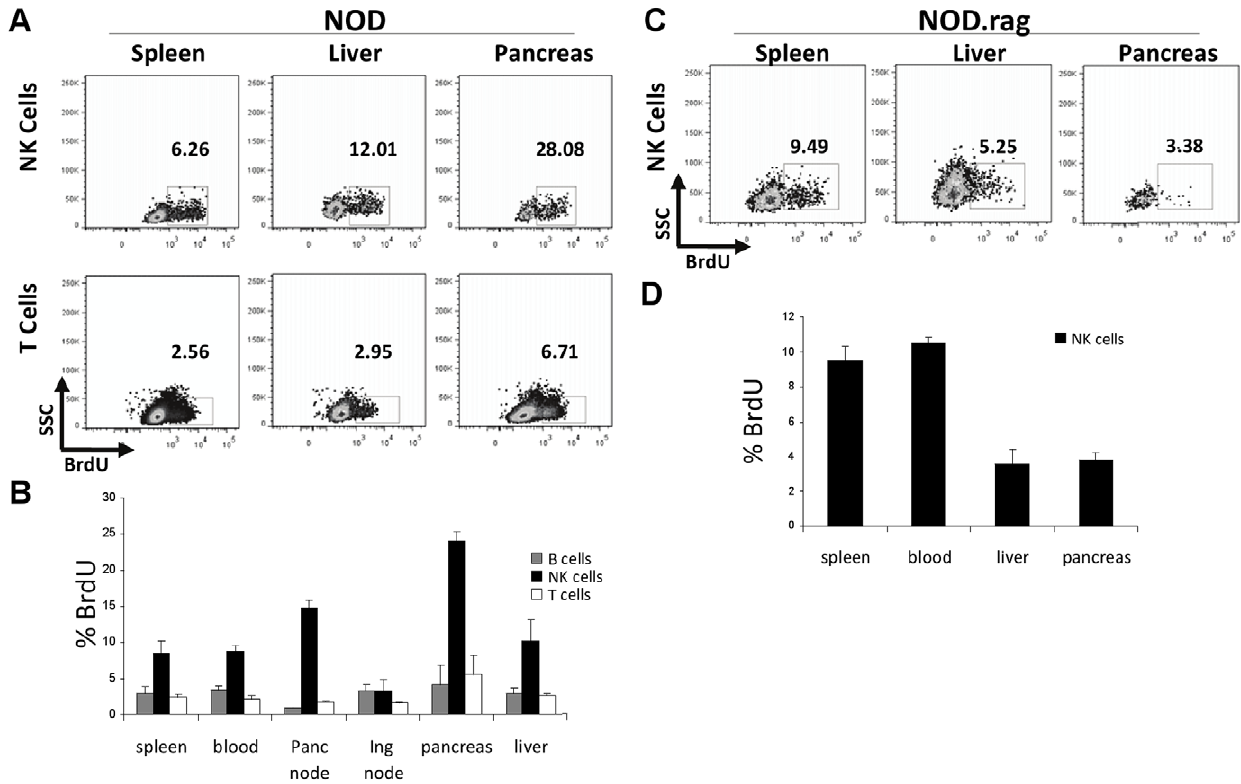
Figure 2. NK cells within the pancreas proliferate at a higher rate than NK cells in the periphery. Plots shown are gated on NKp46 + TCR b 2 lymphocytes day 3 after daily injections of 200 m g BrdU. A) NK cells from NOD mice incorporate BrdU at a higher rate than T cells in the same tissue. B) A higher frequency of NK cells in the pancreas are proliferating compared to NK cells in the spleen of NOD mice, relative to the same comparison of T cells in the pancreas and spleen. Bar graph of three NOD mice in one experiment C) The higher proliferation of pancreatic NK cells in NOD mice is dependent on the presence of adaptive immunity as pancreatic NK cells in Rag2 2 / 2 NOD mice did not incorporate more BrdU than splenic or liver NK cells. D) Bar graph of three Rag2 2 / 2 NOD mice. In some cases mice were pooled to obtain sufficient numbers of NK cells. One representative experiment of three independent experiments is shown.